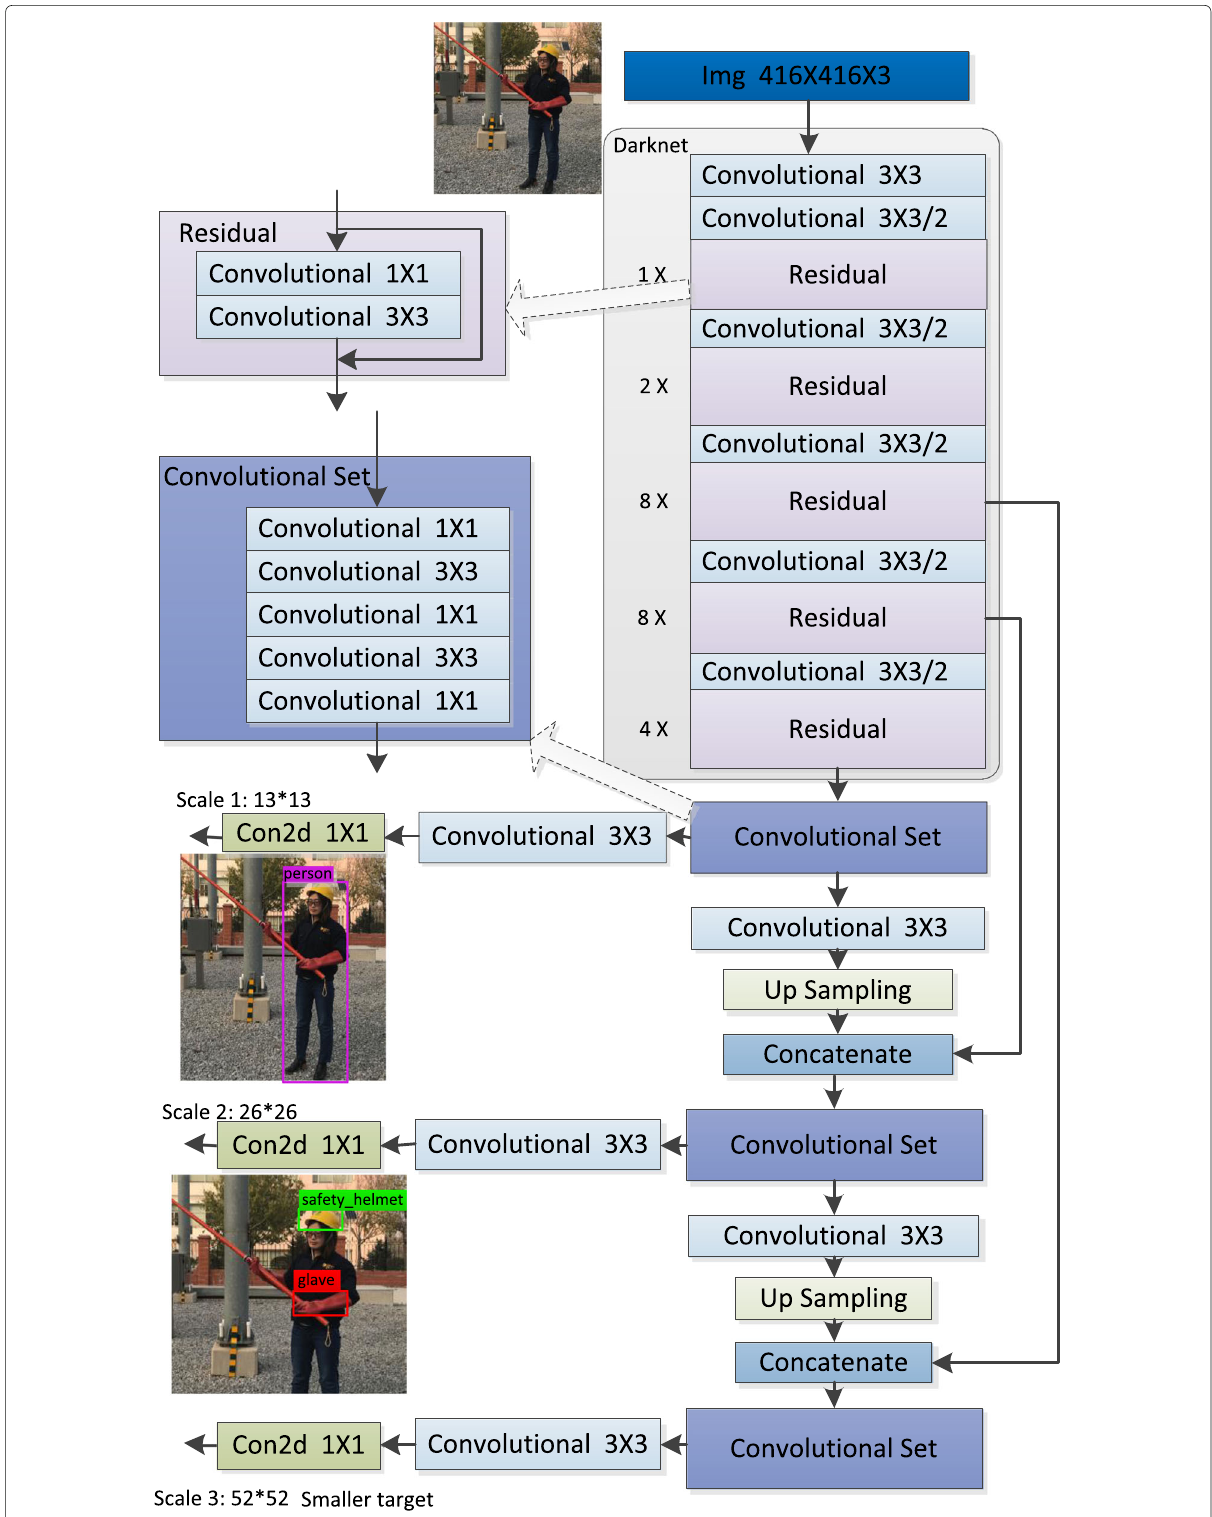
Fig. 7 Yolov3 equipment detection model